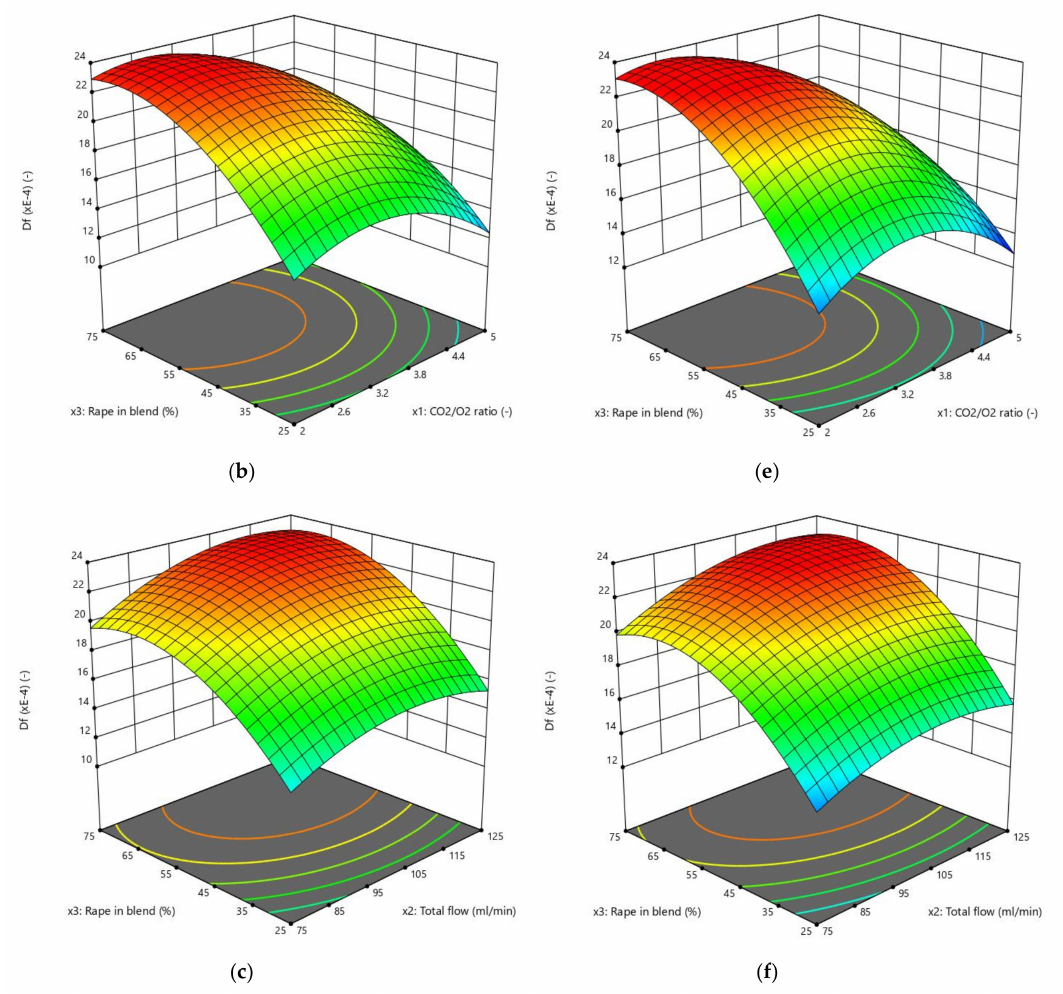
Figure 6. Burnout index ( D f ) response surfaces: ( a – c ) Complete design; and ( d – f ) Box–Behnken design.